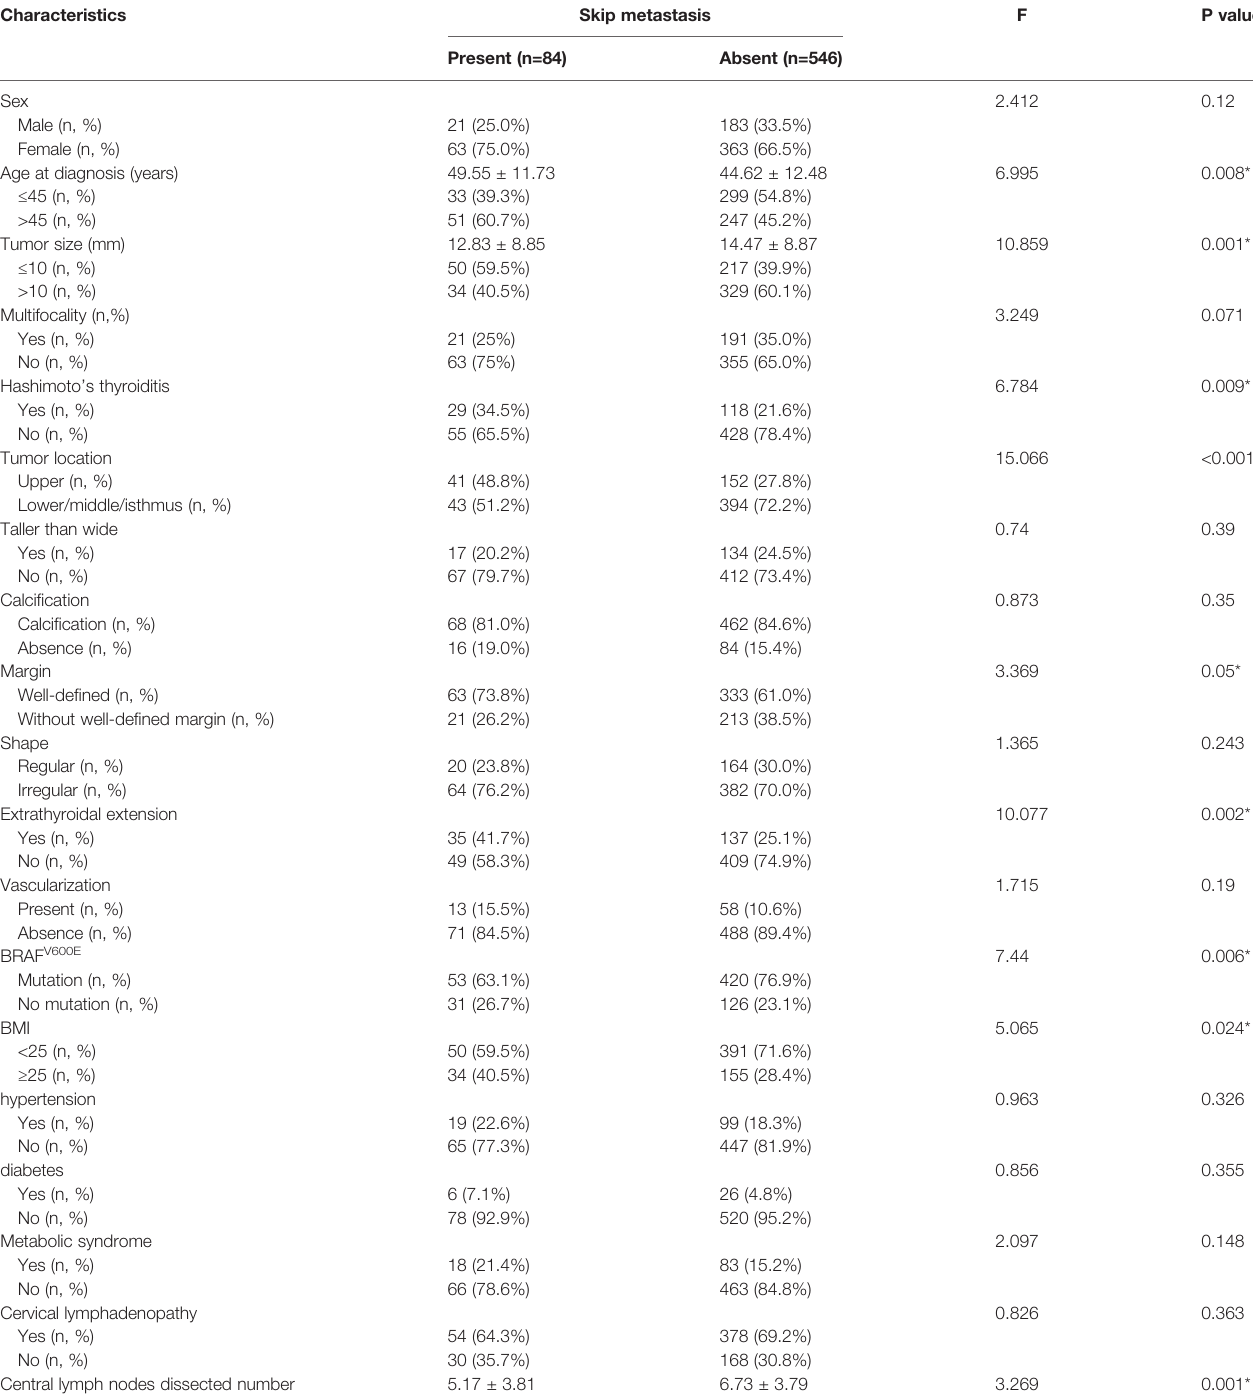
TABLE 1 | Comparison of clinicopathological factors between skip metastasis and non-skip metastasis with PTC. .